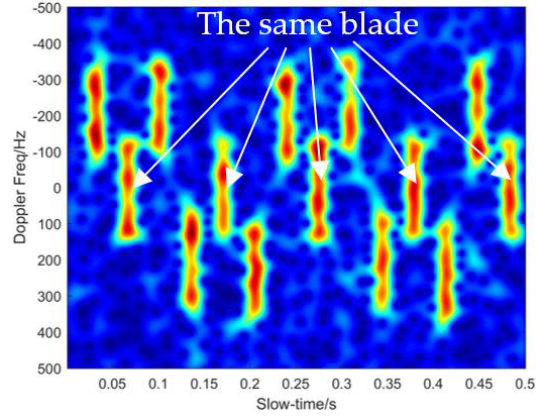
Figure 15. The optimal shifted TFD.